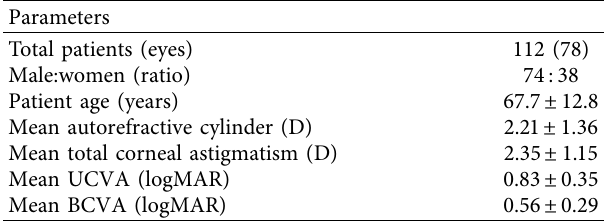
Figure 1: Steep and flat meridian deviation (a) and steep and flat meridian deviation (b). The steep meridian deviation was 23.12 ° l180–156.88l, and the steep and flat meridian deviation was 2.08 ° Table 1: The patient demographics and the preoperative data.